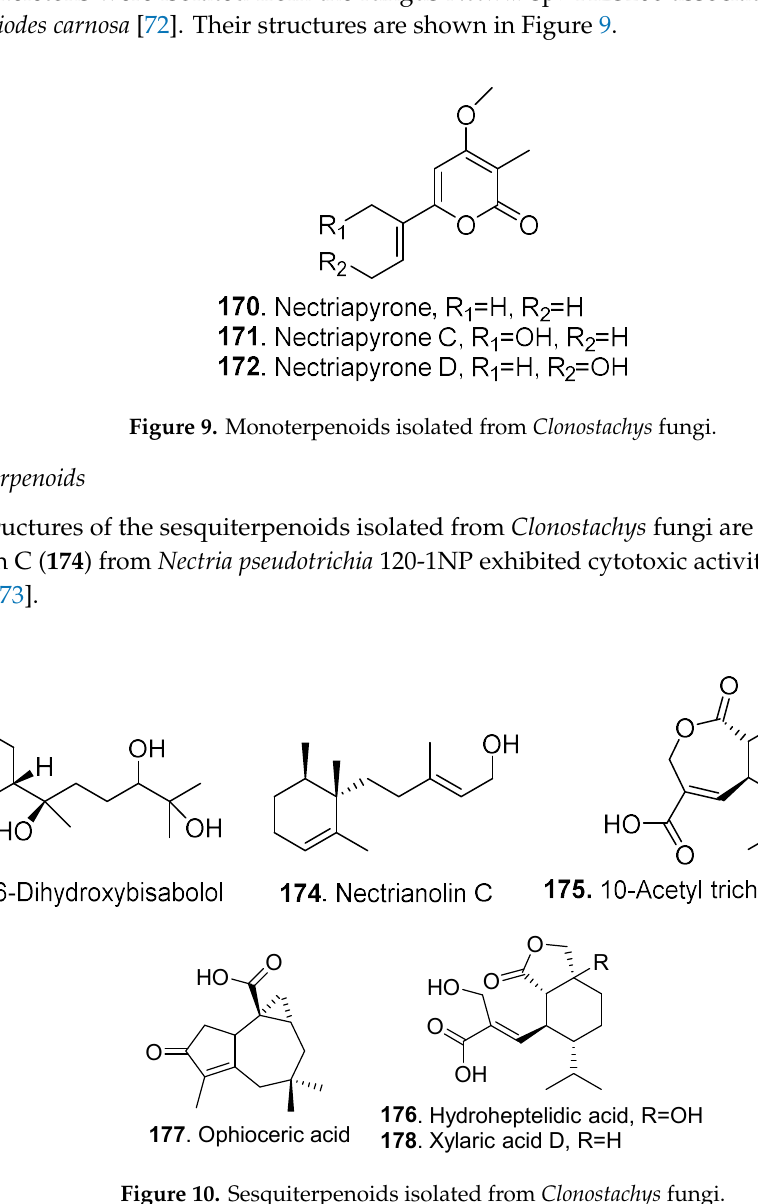
Figure 11. Diterpenoids isolated from Clonostachys fungi.